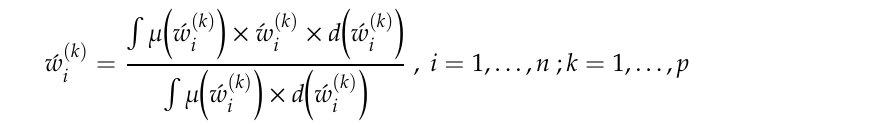
Table 1. Linguistic variables and the equivalent fuzzy interval and defuzzified values [51] .